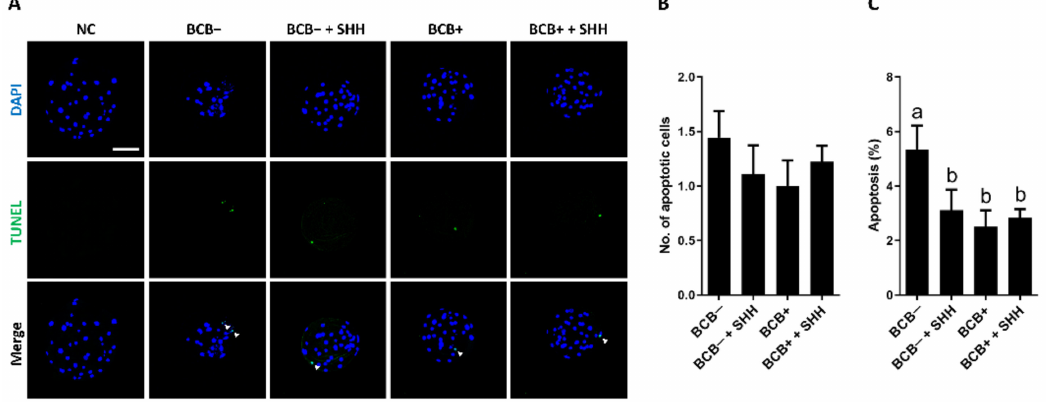
Figure 5. Effect of sonic hedgehog (SHH) protein supplementation during in vitro maturation of brilliant cresyl blue (BCB) − and BCB+ cumulus–oocyte complexes (COCs) on apoptosis levels in parthenogenetic blastocysts. ( A ) Representative photomicrographs of TUNEL staining of partheno- genetic blastocysts in the indicated groups. Quantification of ( B ) numbers and ( C ) proportion of apoptotic cells in the indicated groups. The experiment was independently replicated three times with at least 9 blastocysts per group. Groups indicated by different letters (a and b) represent significant differences ( p < 0.05). NC, negative control; BCB − , BCB non-stained COCs; BCB − + SHH, BCB − COCs supplemented with 0.5 µ g/mL SHH protein; BCB+, BCB stained COCs; BCB+ + SHH, BCB+ COCs supplemented with 0.5 µ g/mL SHH protein. Bar = 100 µ